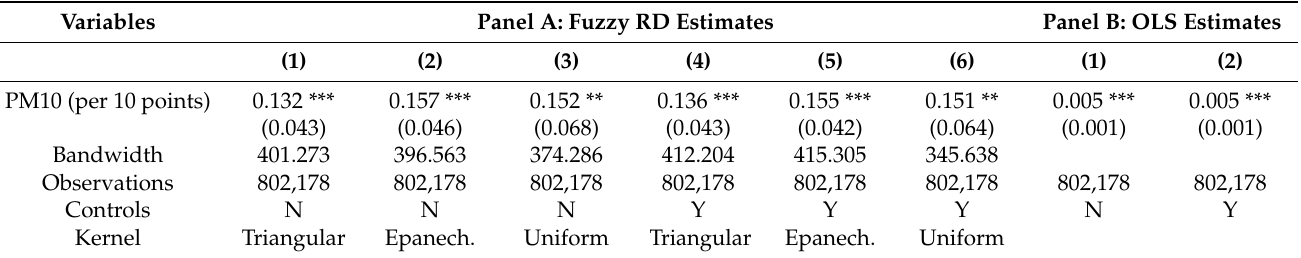
Table 3. Fuzzy RD and OLS estimates of the impacts of PM 10 on